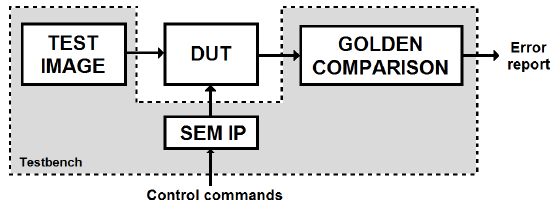
Figure 10. Soft Error Mitigation (SEM) IP-based fault-injection